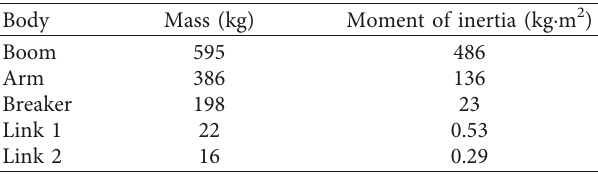
Table 1: Mass and moment of inertia parameters of the rock- breaker model.